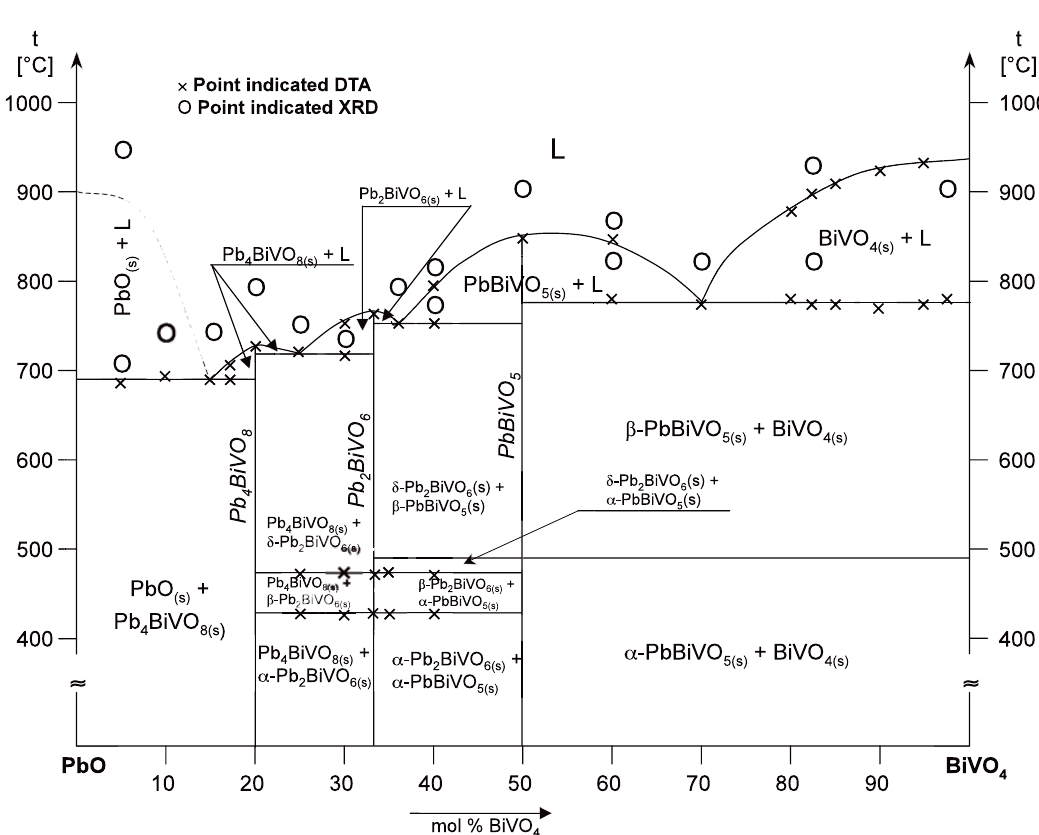
Figure 4. Phase diagram of PbO – BiVO